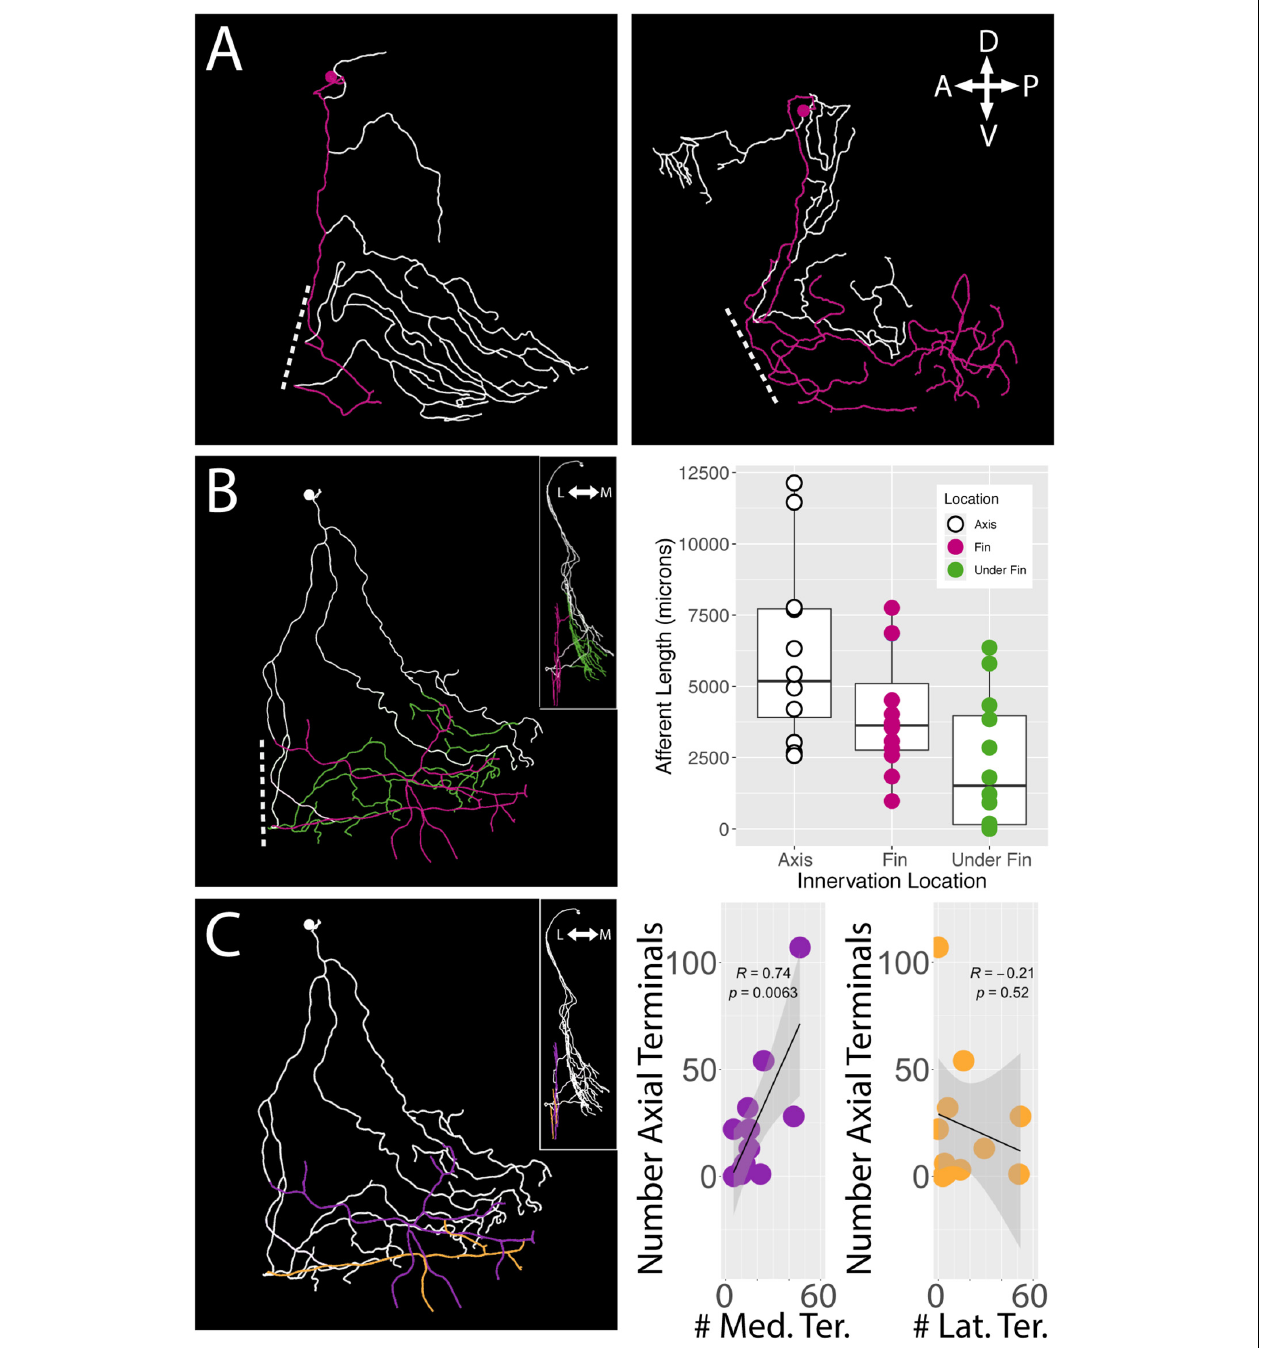
FIGURE 6 | islet2B + neurons innervate both the fin and the body axis. A subset of single neuron reconstructions color coded to indicate the axial innervation in white and the fin only innervation in pink. (A) Left , the cell has very little fin innervation and the primary afferent that enters the fin loops back out of the fin. Right , the cell has far more extensive coverage of the fin. (B) Left , a third cell is color coded for axial innervation (white), fin innervation (pink), and axial innervation under the fin (green). The inset image shows a 90 degree rotation of the same fish with the same color coding. Right , there is a substantial amount of axial innervation across all sampled fish, and the amount of axial, fin, or under the fin innervation varies across a wide range of afferent lengths. In general, the whole population has higher primary afferent lengths on the axis compared to the fin. Notably, some fish have zero to very little innervation under the fin. (C) Left , the same reconstruction in (B) is color coded for medial fin innervation (purple) and lateral fin innervation (orange). The inset again shows the same reconstruction rotated 90 degrees. Right , the number of terminals on the medial fin surface is positively correlated with the number of terminals on the axial surface under the fin (purple graph, correlation, p < 0.01). The number of terminals on the lateral fin surface shows no trend in relation to the number of terminals on the axial surface under the fin (orange graph, correlation, p > 0.05). Anterior is to the left, dorsal is up in reconstructions. In insets, medial is to the left and dorsal is up.